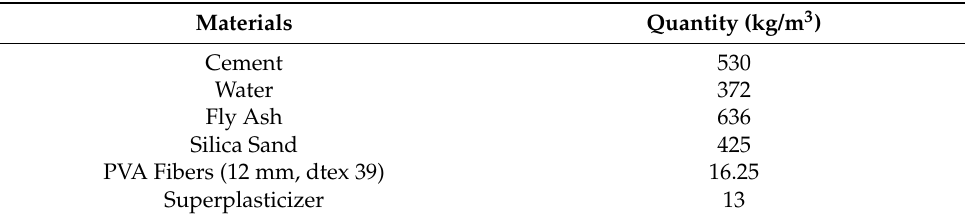
Figure 7. ( a ) Removal of damaged cover to full revelation of the bars; ( b ) Bottom extendable form for lower cover cast; ( c ) Side forms for side and top cover cast; ( d ) Final result of cover replacement. Table 3. Strain-hardening ECC mix design. Compressive strength and corresponding compres-sive strain at peak: f c,ECC = 45 MPa, ε co =